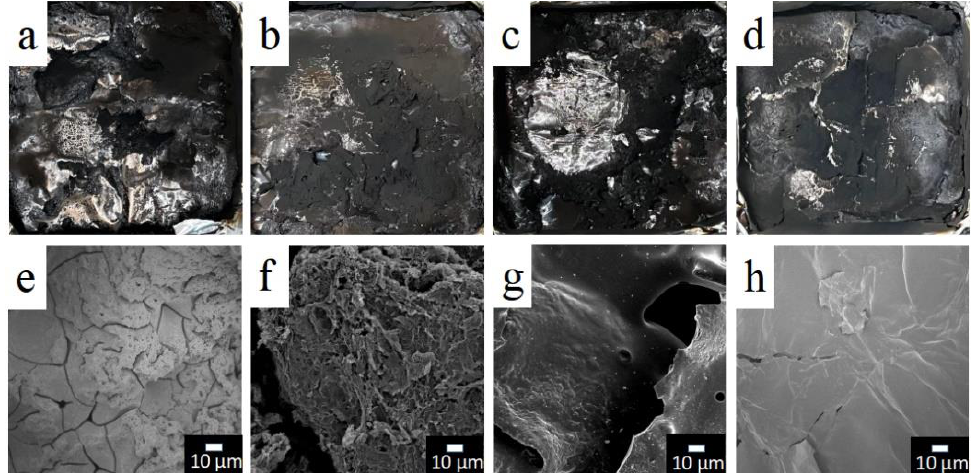
Figure 7. Digital images of char residues for ( a ) pure EP; ( b ) rGO/EP composite; ( c ) DOPO-M/EP composite; ( d ) DOPO-M-rGO/EP composite and SEM images of char residues for ( e ) pure EP; ( f ) rGO/EP composite; ( g ) DOPO-M/EP composite; ( h ) DOPO-M-rGO/EP composite after cone calorimeter test (the mass fractions of additive in the composites are all 1.5%).